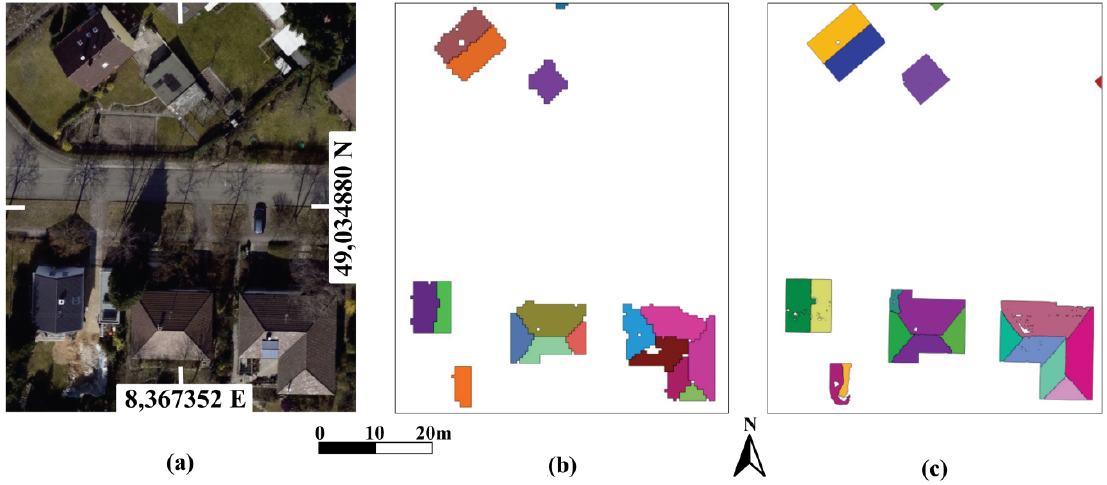
Figure 9. Extracted roof planes of the Karlsruhe test site. ( a ) Aerial image; ( b ) Roof planes extracted form LiDAR DSM; ( c ) Roof planes extracted from DSM derived from aerial images. Copyright: Datengrundlage © Stadt Karlsruhe, Liegenschaftsamt.